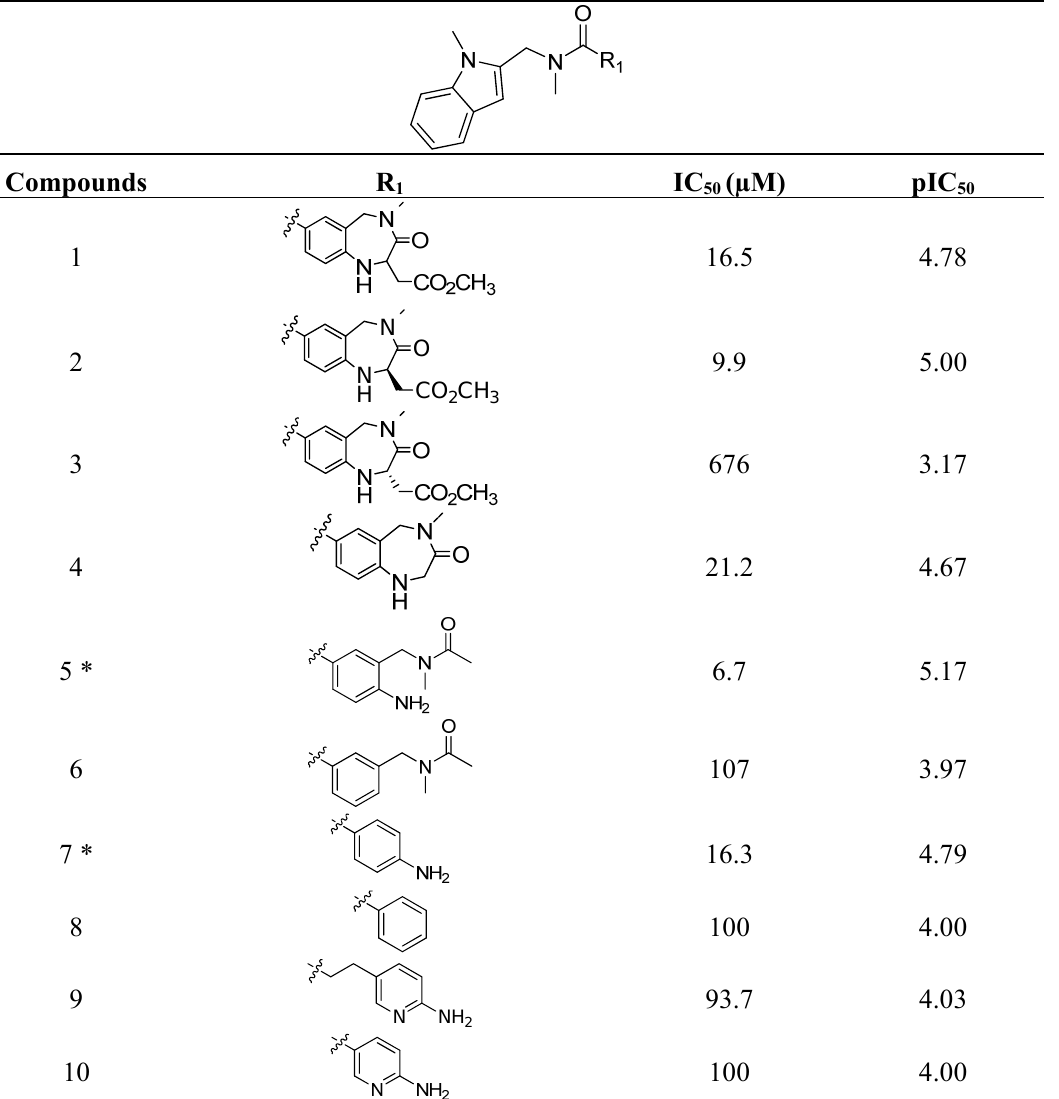
values of the compounds in the 50